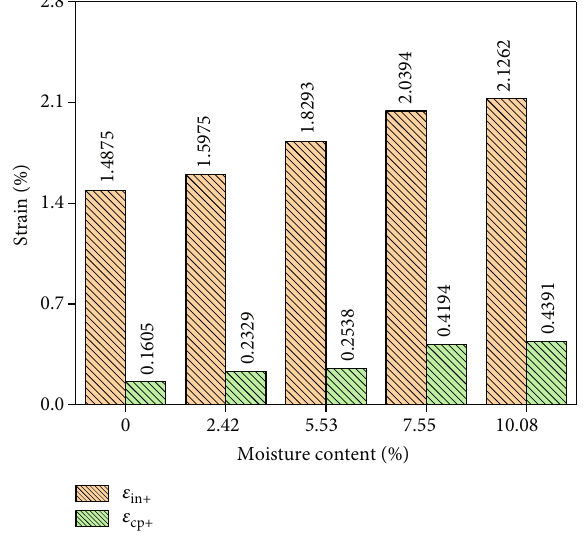
Figure 7: Variation curves of instantaneous strain and creep strain with water content during creep